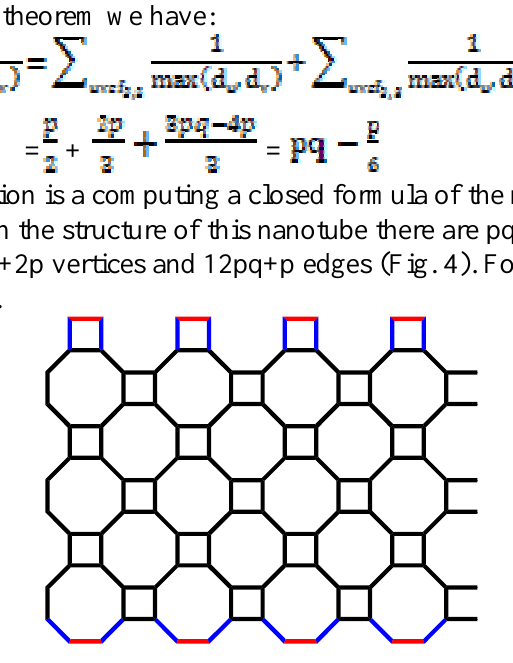
C [p,q] nanotube, with p=4 and q=3 4 8